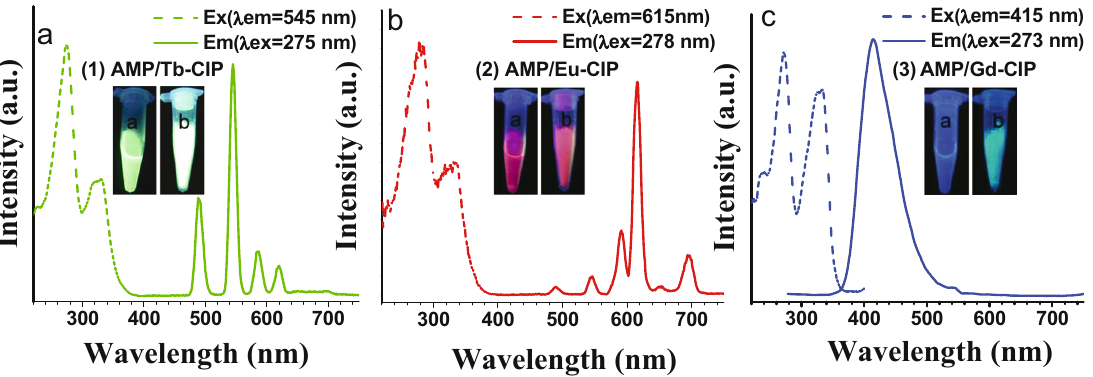
Figure 3: Excitation and emission spectra of AMP/Tb - CIP ( a ) , AMP/Eu - CIP ( b ) , and AMP/Gd - CIP ( c ) . Inset is the corresponding images of their solutions and solid powder under a common UV lamp.